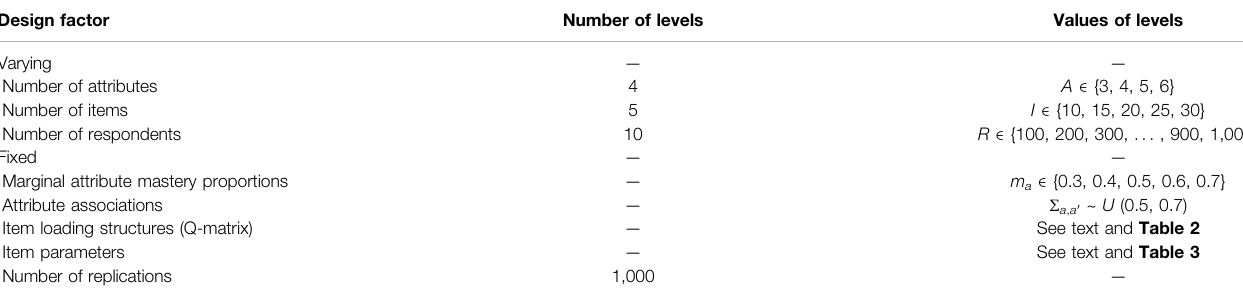
TABLE 1 | Simulation study design and conditions for data generation. Design